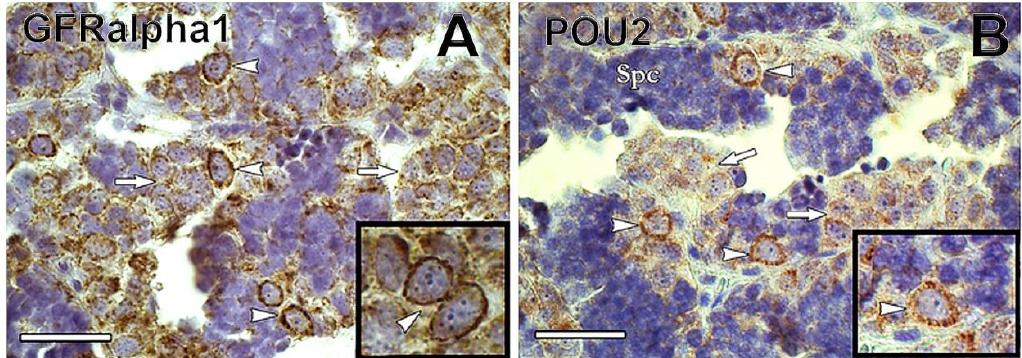
Figure 5. ( A ) Immunoreactivity of GFRα1 was found preferentially in type A undifferentiated spermatogonia (arrowheads) of common carp. In contrast, GFRα1 immunoreactivity decreased in differentiated spermatogonia (arrows). The inset shows GFRα1-positive undifferentiated spermatogonia (arrowheads). ( B ) POU2 was detected in common carp type A undifferentiated spermatogonia (arrowheads), whereas its immunoreactivity decreased in differentiated spermatogonia (arrows). Inset shows POU2-positive undifferentiated spermatogonia. Spc = spermatocyte. Scale bar: 25 µm.